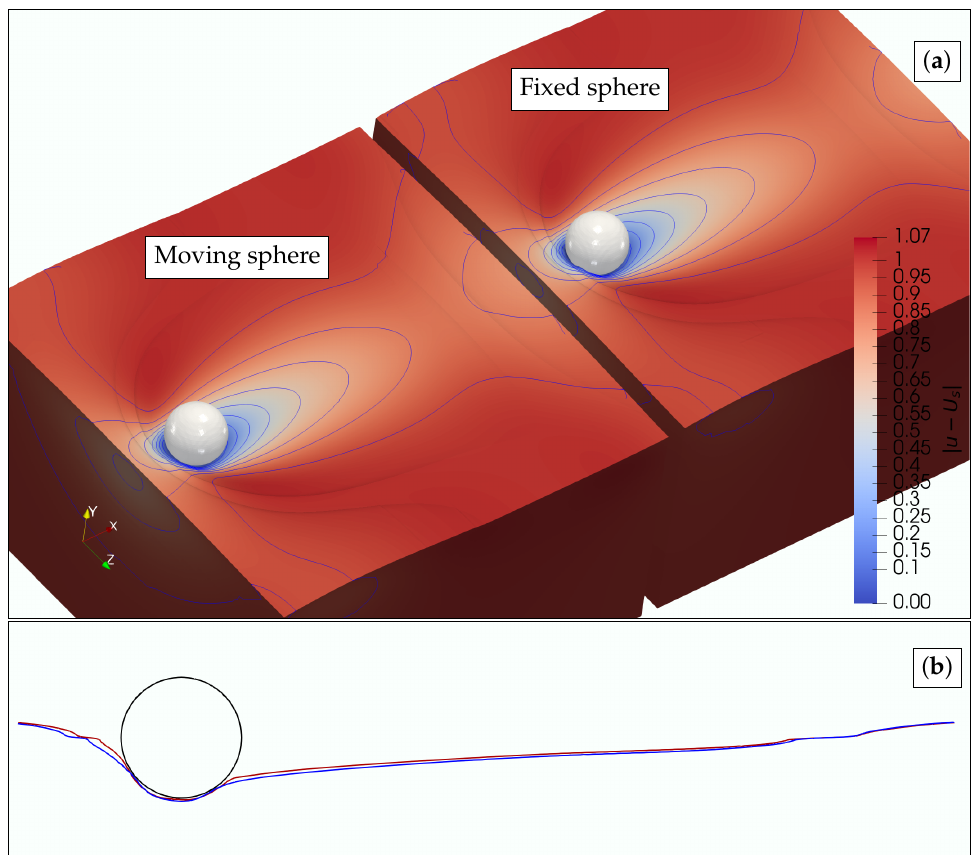
Figure 17. Galilean invariance test in three dimensions. ( a ) The case of a moving sphere and fixed fluids (left) and a fixed sphere and moving fluids (right) at time t = 0.625. The interface between the fluids is shown. The color and isolines indicate the norm of the relative velocity the XY -plane slices through the sphere in ( a ), with the blue curve corresponding to the moving sphere and the red to the fixed sphere. The level of refinement used was J max = 7 so that the mesh is rather coarse compared to the previous two-dimensional case but still shows very good